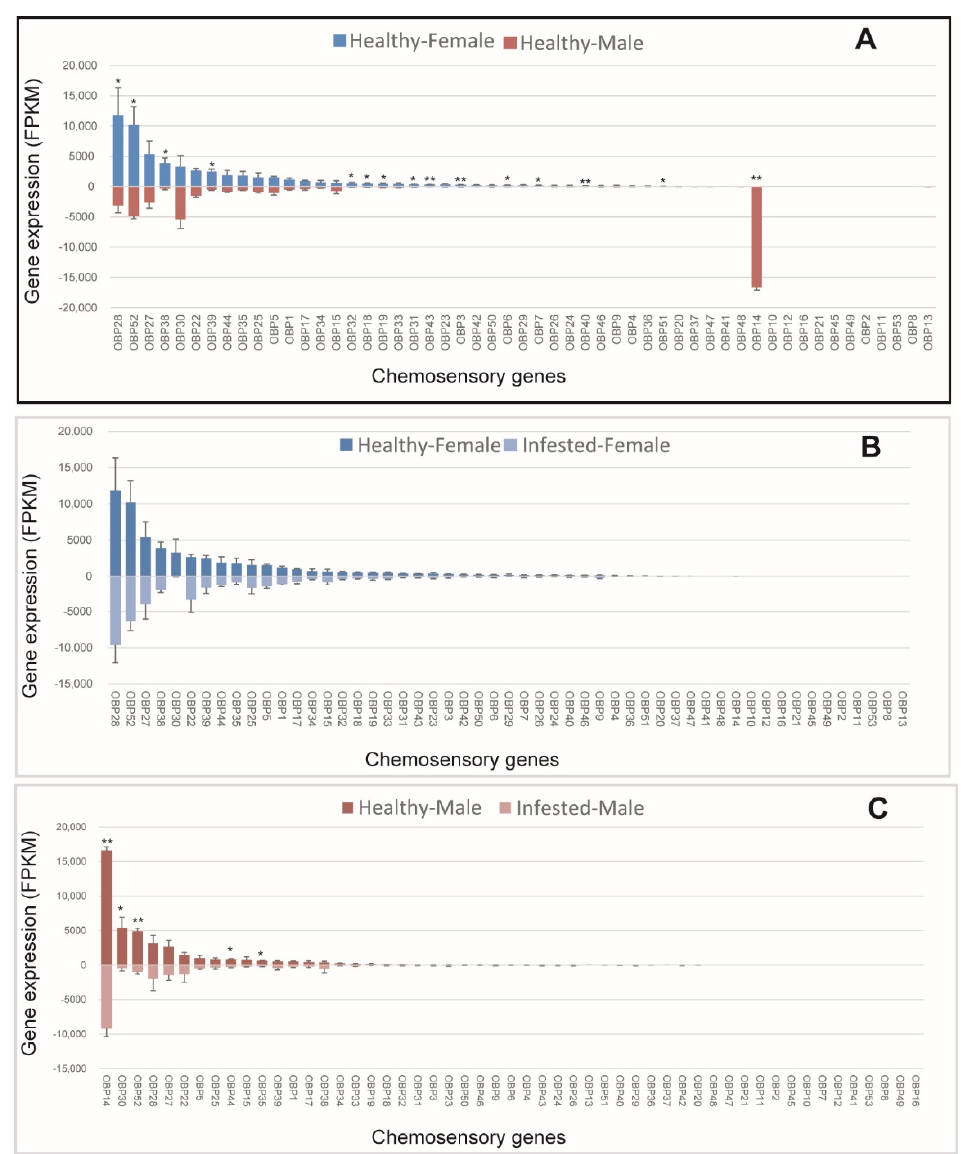
Figure 1. Expression patterns of odorant-binding protein in healthy and Bursaphelenchus xylophilus -infested Monochamus saltuarius . ( A ) Differences between sexes of healthy M. saltuarius ; ( B ) Differences between healthy and infested female M. saltuarius ; ( C ) Differences between healthy and infested male M. saltuarius . Transcript levels are expressed as reads per kilobase of exon per million mapped reads (RPKM), and the expression data were shown as mean ±SE. The stars above each bar of figure indicate significant differences ( p < 0.05 * and p < 0.05 **).